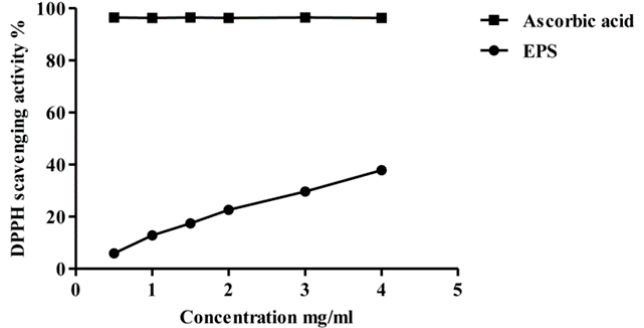
Figure 7. 2,2-Diphenyl-1-picrylhydrazyl (DPPH) radicals scavenging activity of different concentrations of MOE6-EPS (0.5, 1, 1.5, 2, 3, 4 mg/mL) from Streptomyces sp. MOE6 compared to that of ascorbic acid (0.5, 1, 1.5, 2, 3, 4 mg/mL) as a positive control. Values are means ± SD ( n = 3). 100% ( w/v ) of DPPH